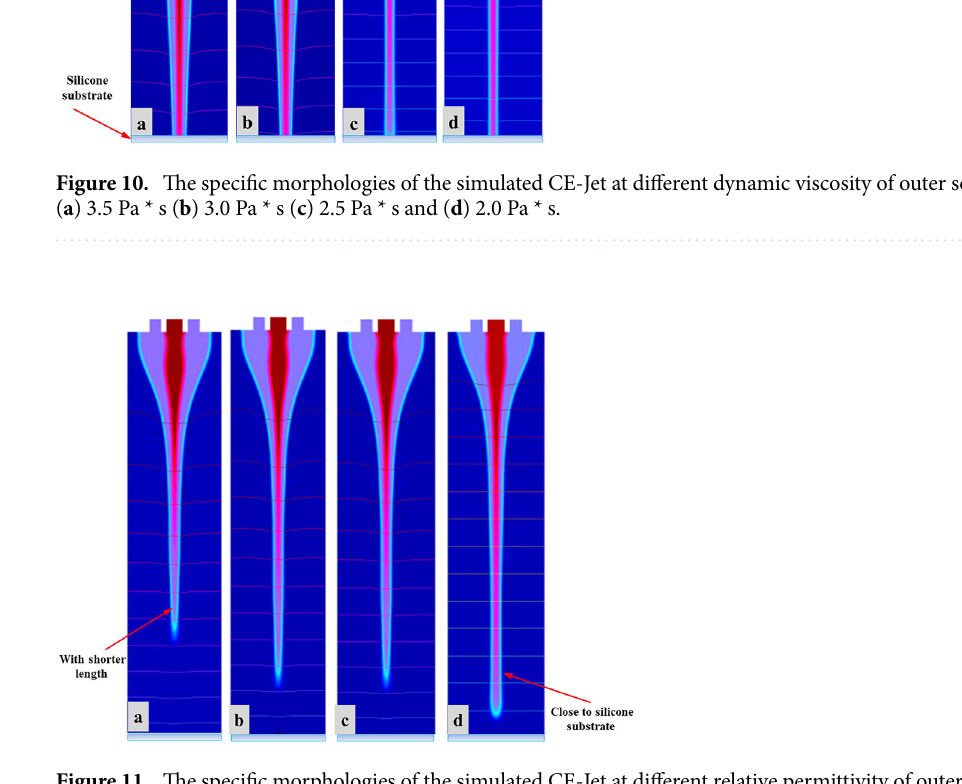
Figure 11. The specific morphologies of the simulated CE-Jet at different relative permittivity of outer solution ( a ) 150 ( b ) 100 ( c ) 50 and ( d )